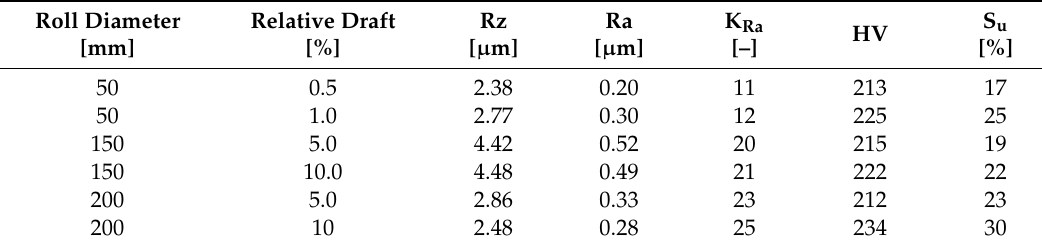
Table 2. The indicator decrease in surface roughness (K Ra ) and strengthening (S u ) of the Ni–5%Al alloy coatings after burnishing and rolling.